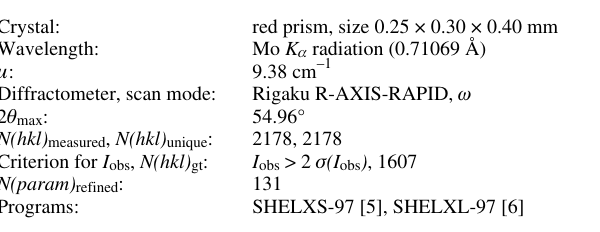
Table 1. Data collection and handling.